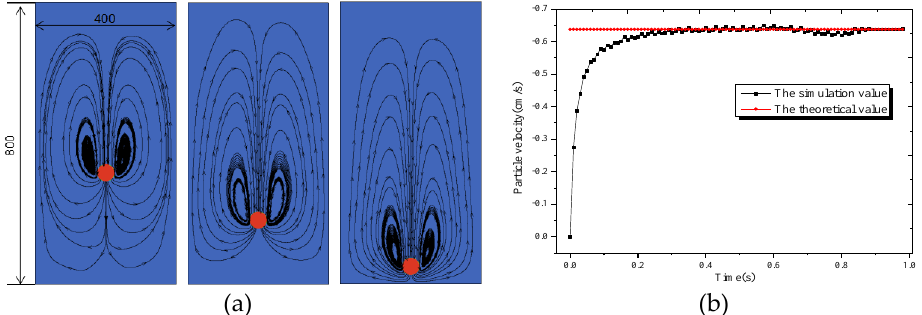
Figure 3. Diagram of circular particle settlement : ( a ) Flow field; ( b ) Settlement velocity.